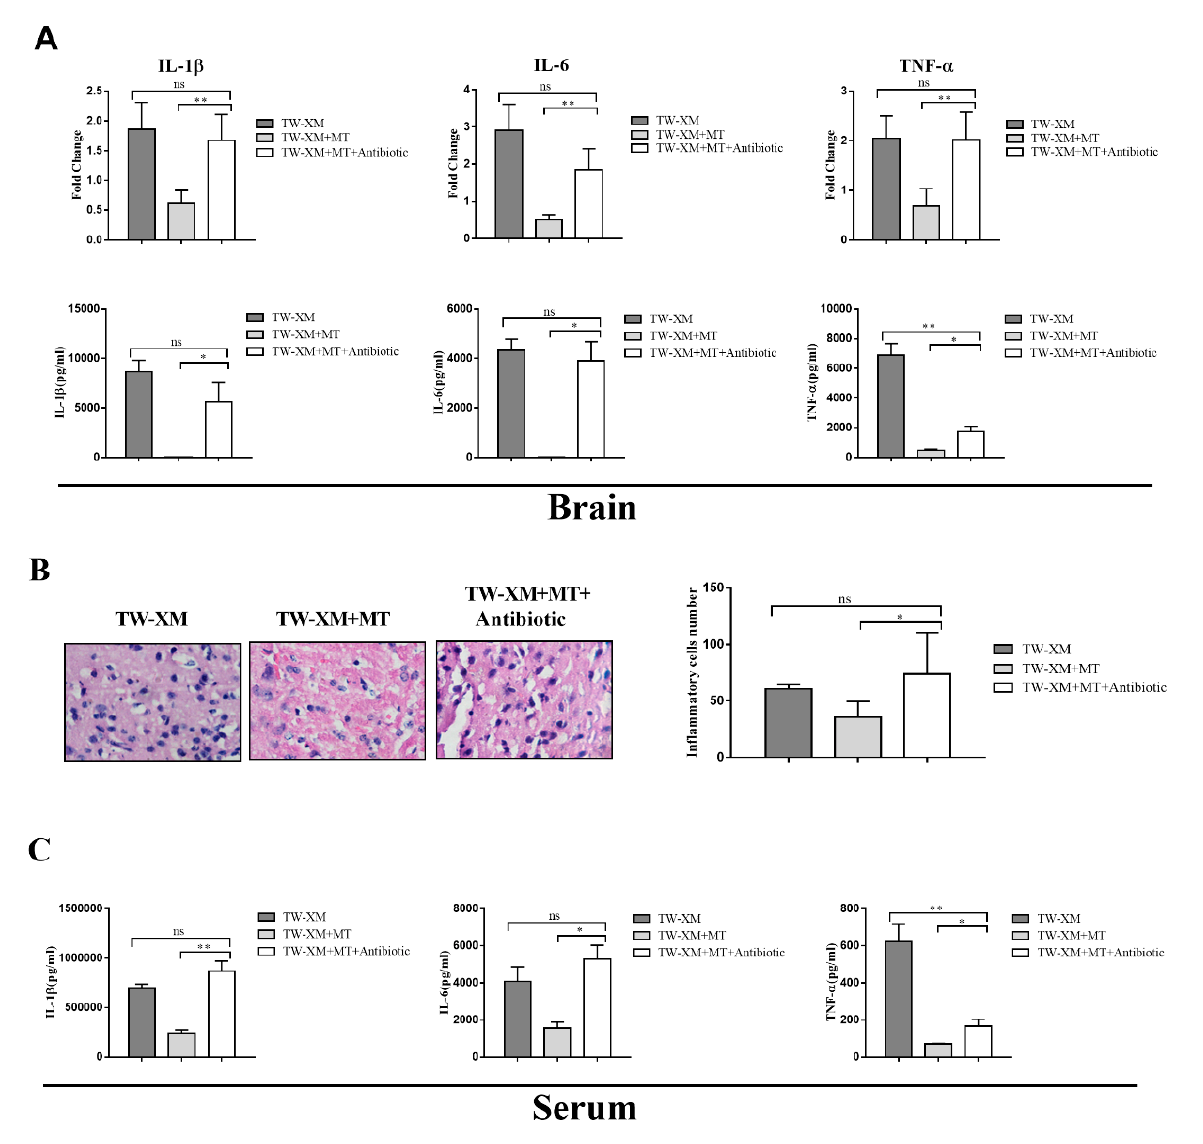
Figure 7. In the absence of intestinal microbiota, melatonin failed to inhibit the inflammatory response of the brain and serum and the infiltration of neutrophils in the brain in APEC TW − XM − infected mice. ( A ) The mRNA expression and production of inflammatory factors in brain tissues of mice in each group by qPCR. ( B ) The infiltration of neutrophils in the brain by hematoxylin–eosin staining (bar=100 µ m). ( C ) The production of inflammatory factors in serum of mice in each group by ELISA. All data were determined by one-way ANOVA and expressed as means ± SEM. * p < 0.05, ** p < 0.01, ns p > 0.05.